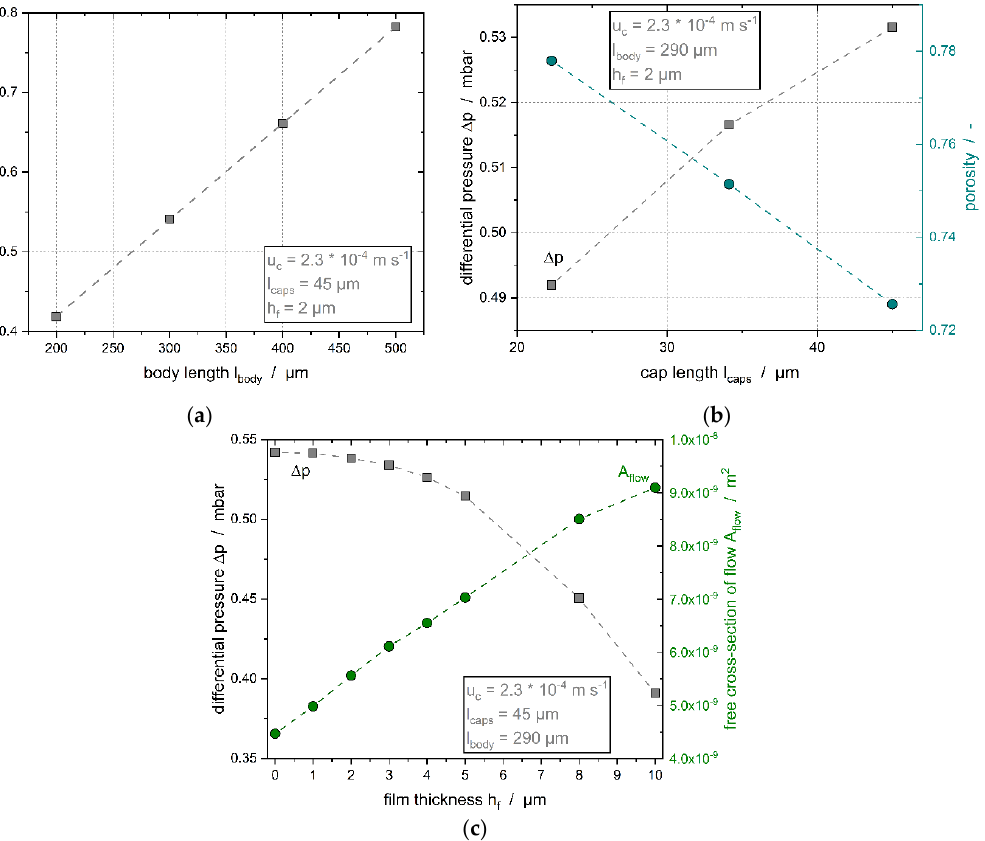
Figure 9. Influence of ( a ) body length l body , ( b ) cap length l cap and ( c ) film thickness h f on the pressure drop in the minichannel. The lines presented are guides for the eye.